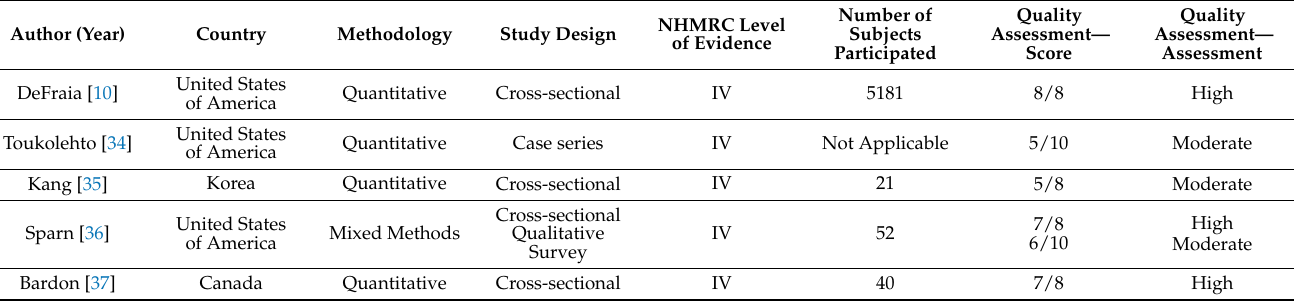
Table 1. Study characteristics.